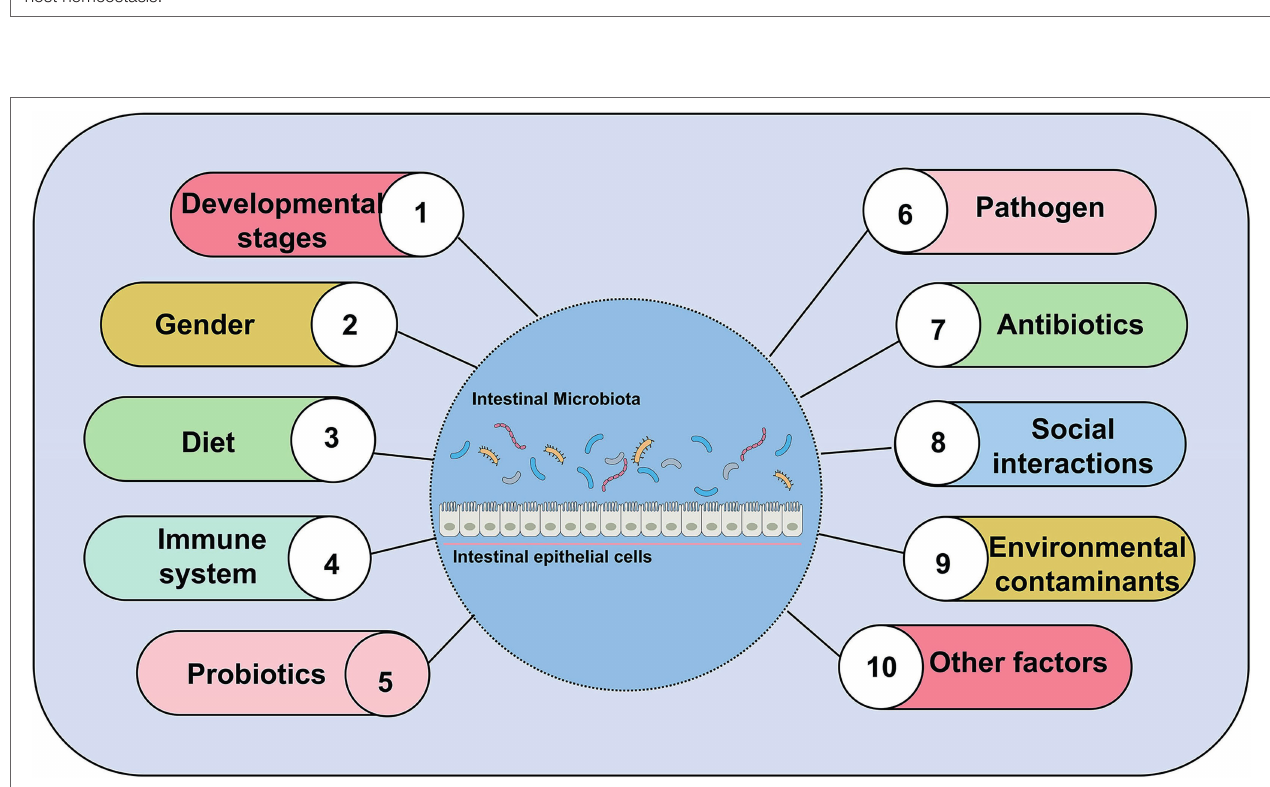
FIGURE 2 | Gut microbiota can induce LPS toxicity in CV zebrafish. In GF zebrafish, the gut is sterile and therefore does not induce LPS toxicity. Although gut microbiota in CV zebrafish can induce LPS toxicity, e.g., infectious shock, and even death, there is also negative feedback regulation in CV zebrafish to maintain host homeostasis.